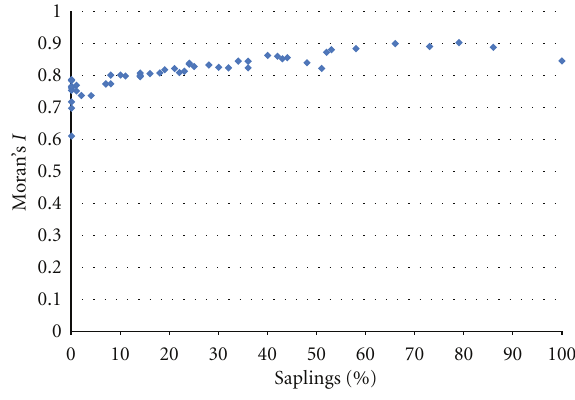
Figure 15: Moran’s I versus saplings.